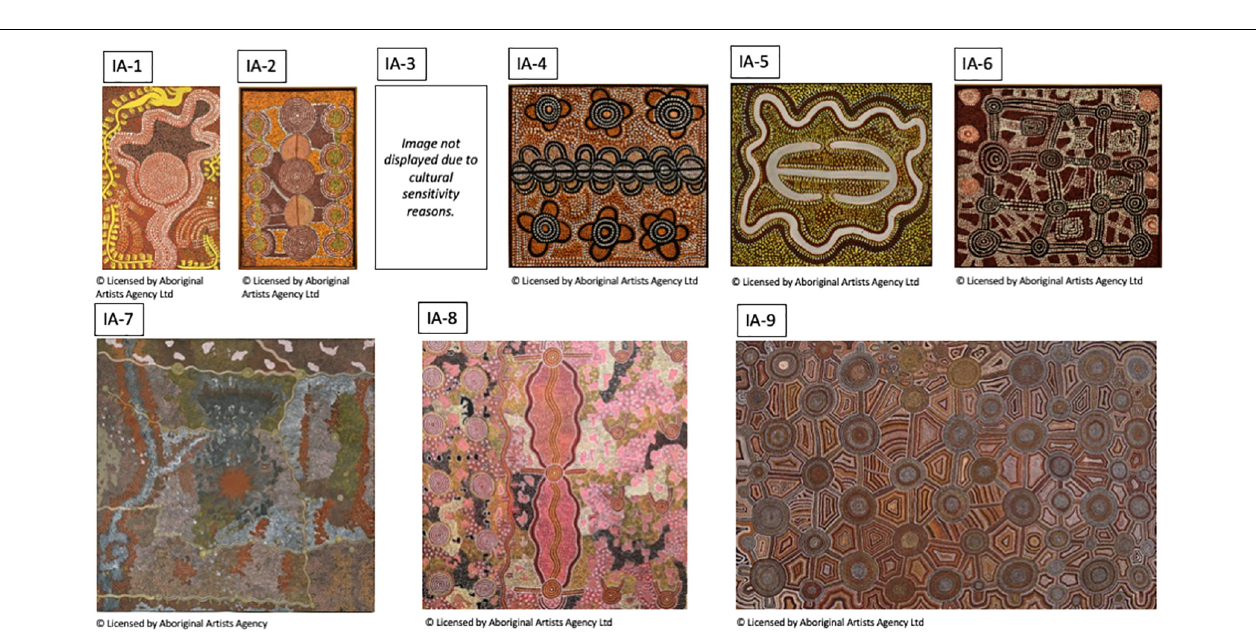
FIGURE 1 | Non-Indigenous Australian paintings used in this study. For detailed description of artworks see Table 1 .